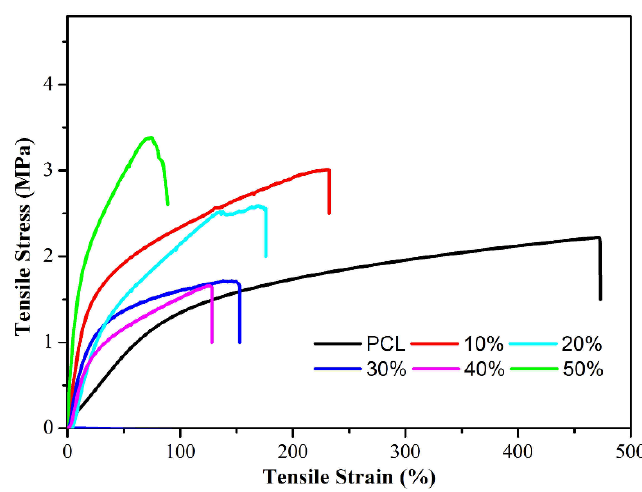
Figure 6. Stress‒strain plots of neat PCL fibers and PCL/(n%)PCD (n = 10, 20, 30, 40, 50) composites. Figure 6. Stress–strain plots of neat PCL fibers and PCL/(n%)PCD ( n = 10, 20, 30, 40, 50)